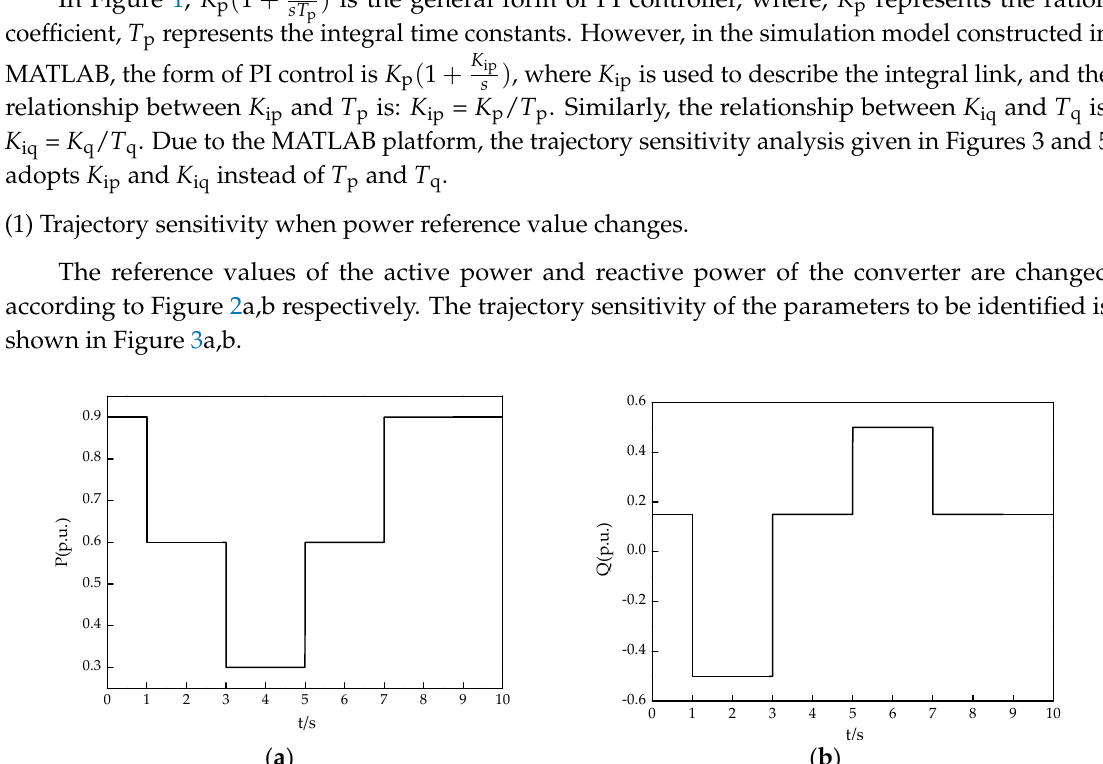
Figure 1. Control structure diagram of the photovoltaic (PV) unit.